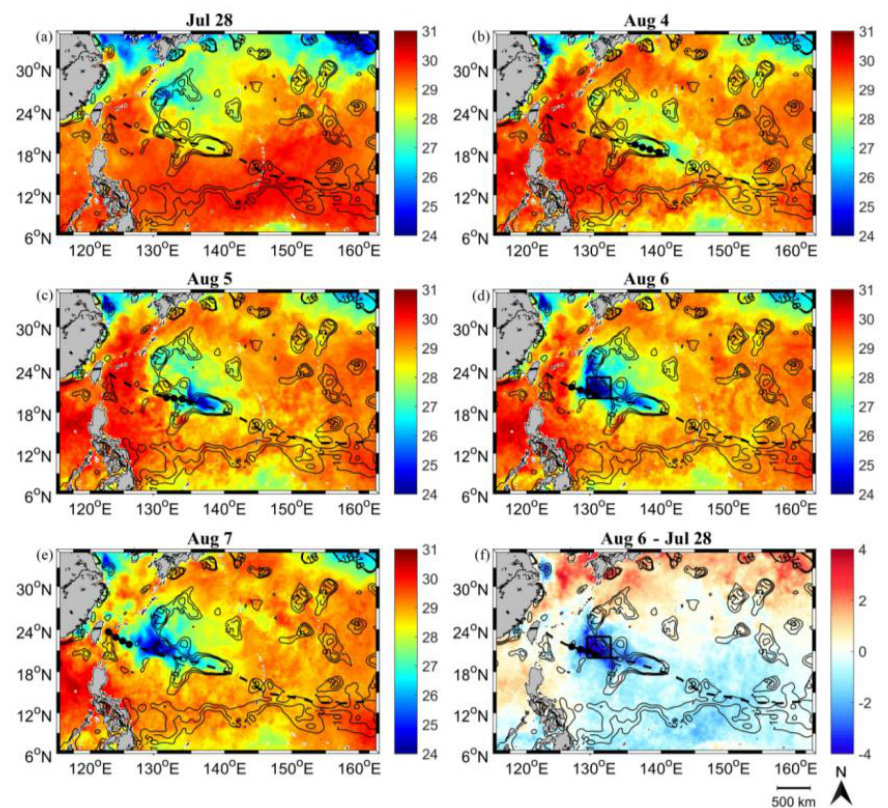
Figure 2. Distribution of sea surface temperature (SST) (°C) before and during Typhoon Soudelor passed by. ( a ) SST on July 28, before Typhoon Soudelor was generated; ( b – e ) SST during the typhoon; ( f ) variation of SST during (on 6 August) and before (on 28 July) Typhoon Soudelor. Overlaid is sea surface height anomaly (SSHA) (contours, unit: cm) on 28 July 2015. Only negative values are plotted, with closed contours indicating pre-existing CEs. The black dashed line denotes the typhoon track and the dot denotes the center of the typhoon on each day. The black rectangle in ( d , f ) represents a typical CE region.